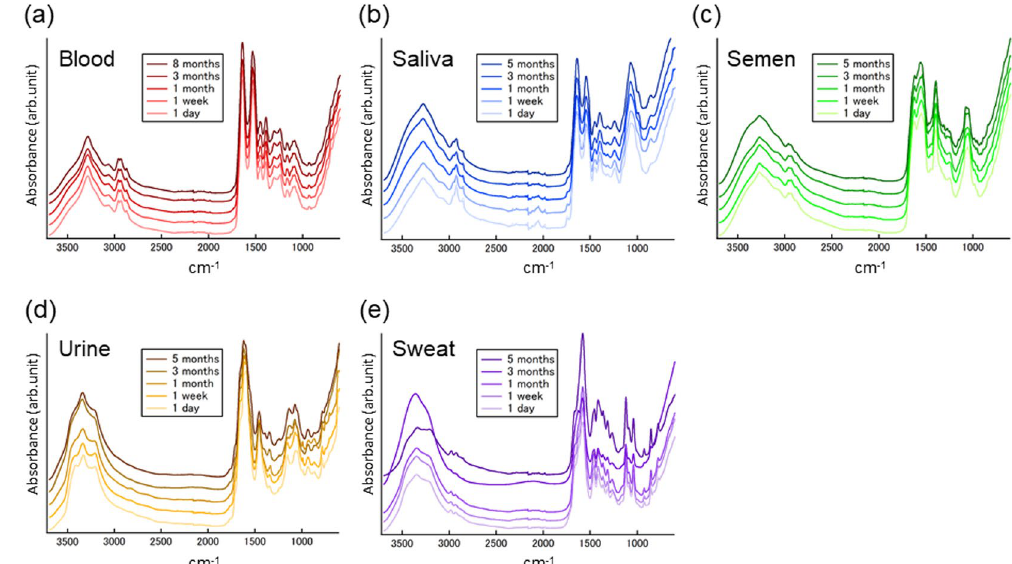
Figure 4. Spectral changes in the five BF types with aging over several months. Average ATR FT-IR spectra of peripheral blood ( a ), saliva ( b ), semen ( c ), urine ( d ) and sweat ( e ) aged from one day to eight months. The lighter color spectra indicate those of fresher BF samples. The darker color spectra correspond to those of aged BF samples. The ages of the BF samples are given in each